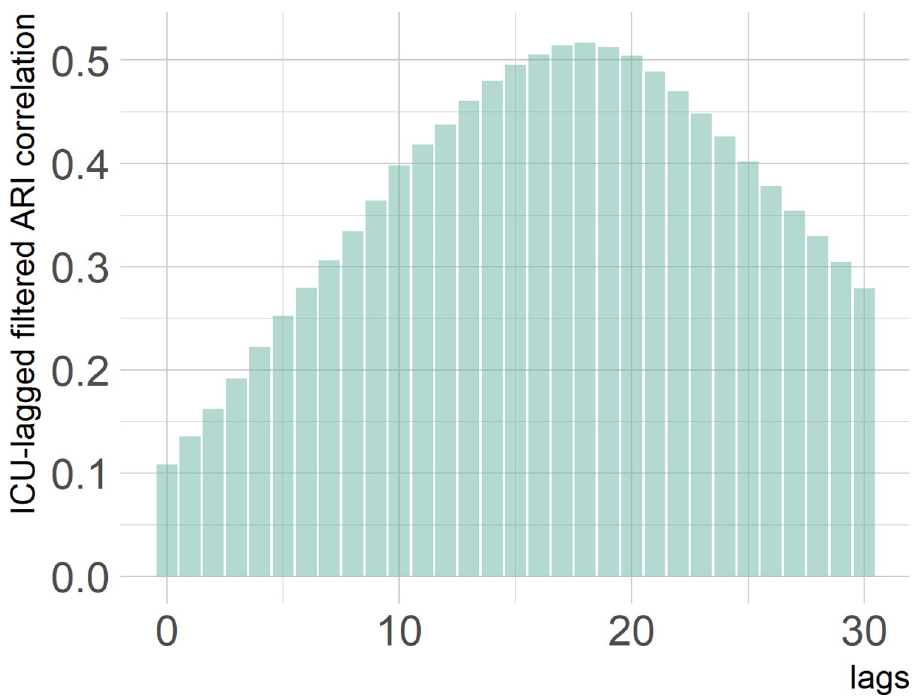
Fig 2. Cross-correlogram between filtered ARI rates and ICU occupancy rates (right). The x-axis indicates the number of lags.